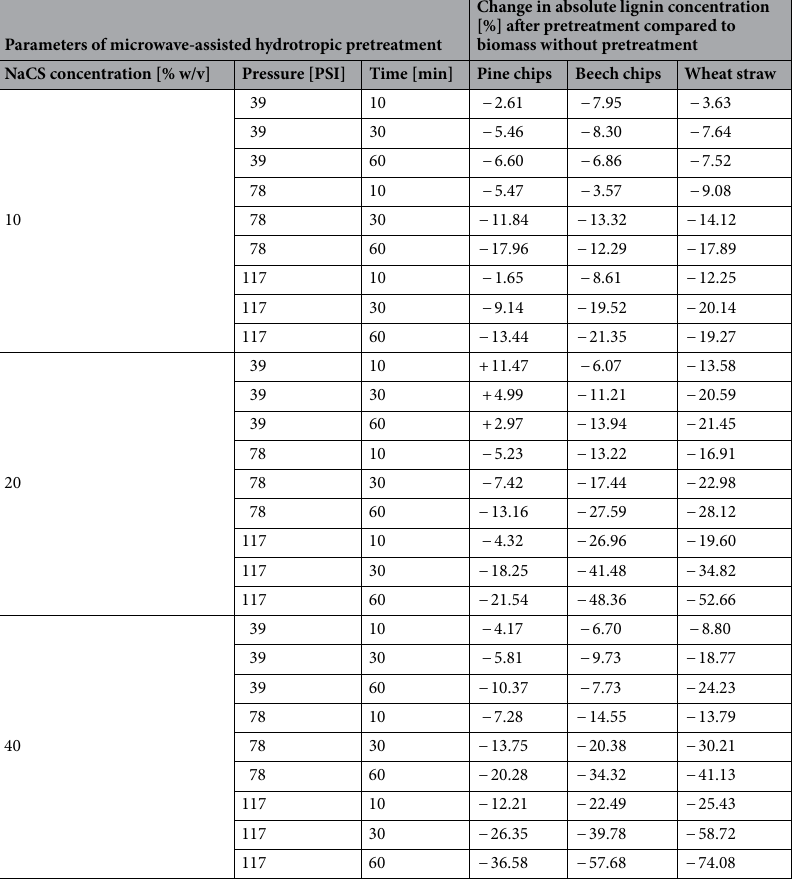
Table 4. Change in absolute lignin concentration after microwave-assisted hydrotropic pretreatment.